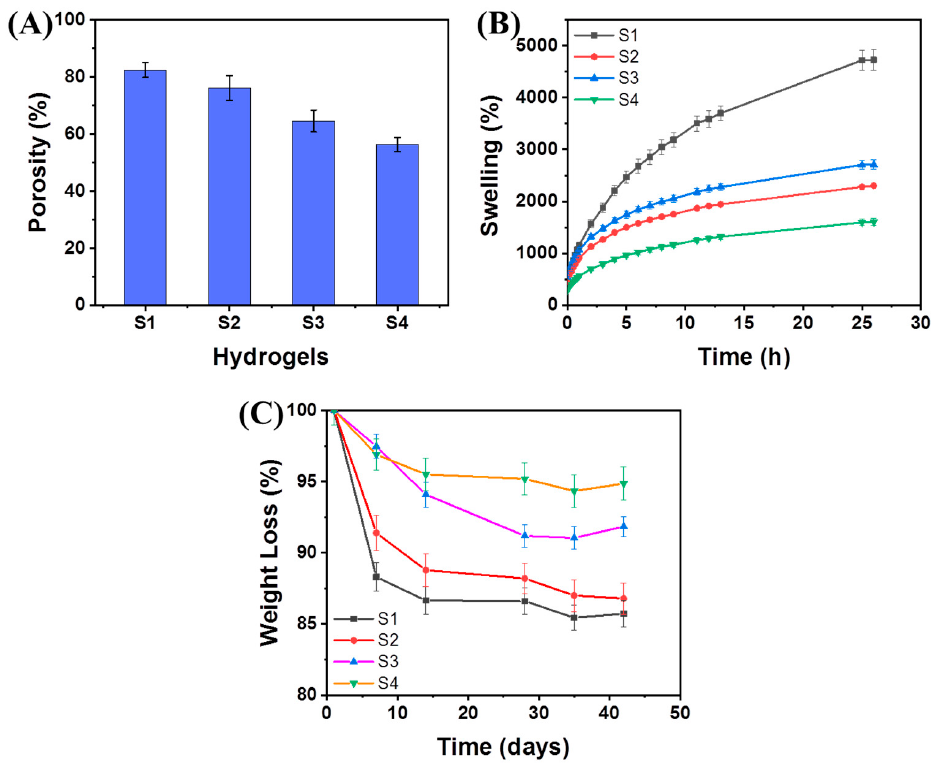
Figure 4. ( A ) Porosity (%); ( B ) swelling behavior (water) vs. time (h); and ( C ) degradation behavior (PBS) vs. time (days) for hybrid hydrogels. (PBS) vs. time (days) for hybrid